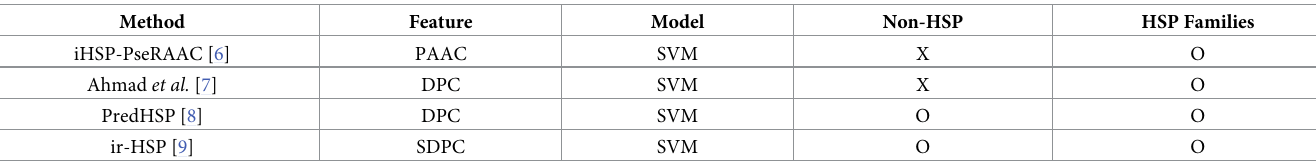
Table 1. Summary of related